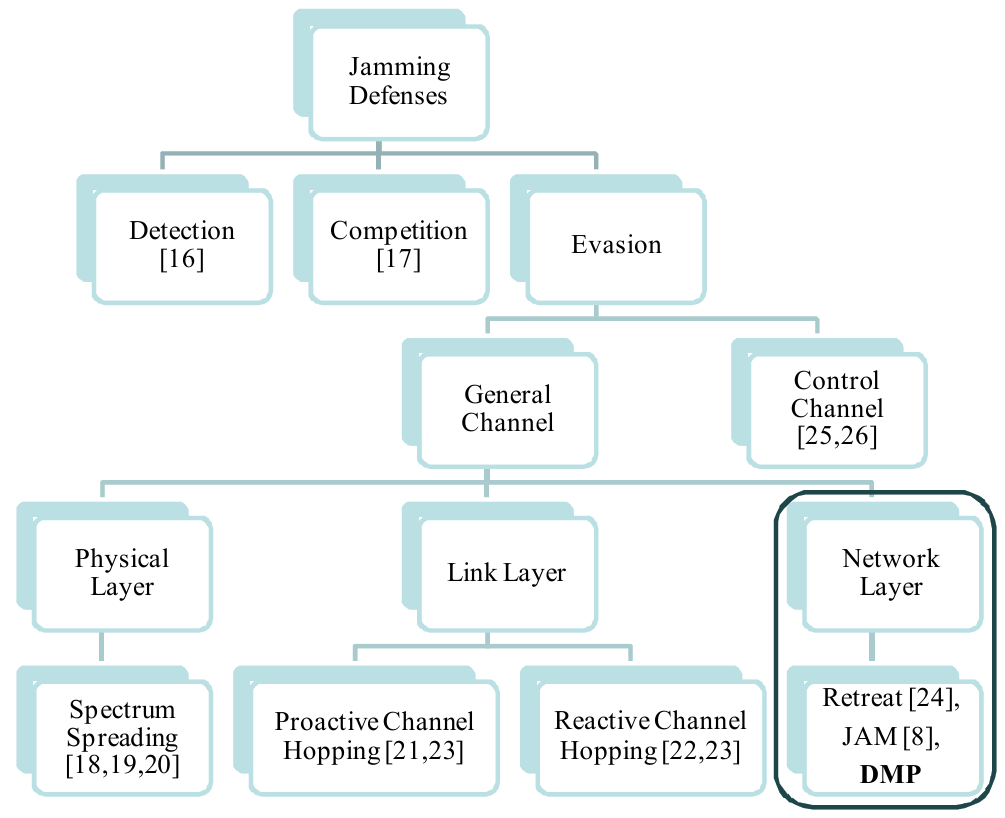
Figure 2. Existing jamming defenses and